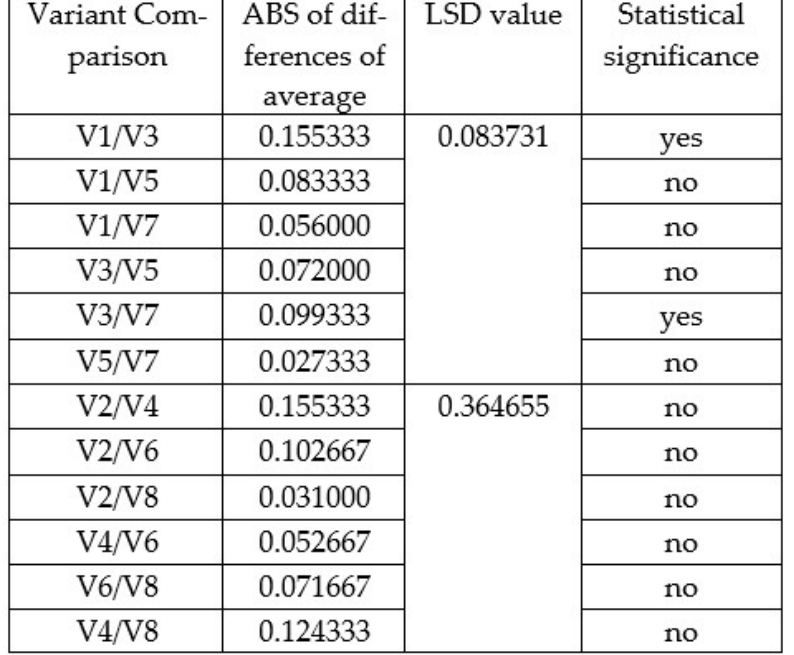
Figure 9. The statistical significance determined by LSD (Least Significant Difference) test values of Lepidium sativum L. sprouts weight on gauze (V1 control, illuminated with sunlight; V3, illuminated with white LED; V5, illuminated with blue LED; and V7, illuminated with red LED experimental variant) or biochar (V2 control, illuminated with sunlight; V4, illuminated with white LED; V6, illuminated with blue LED; and V8, illuminated with red LED experimental variant,) t crit value = 1.980626002.